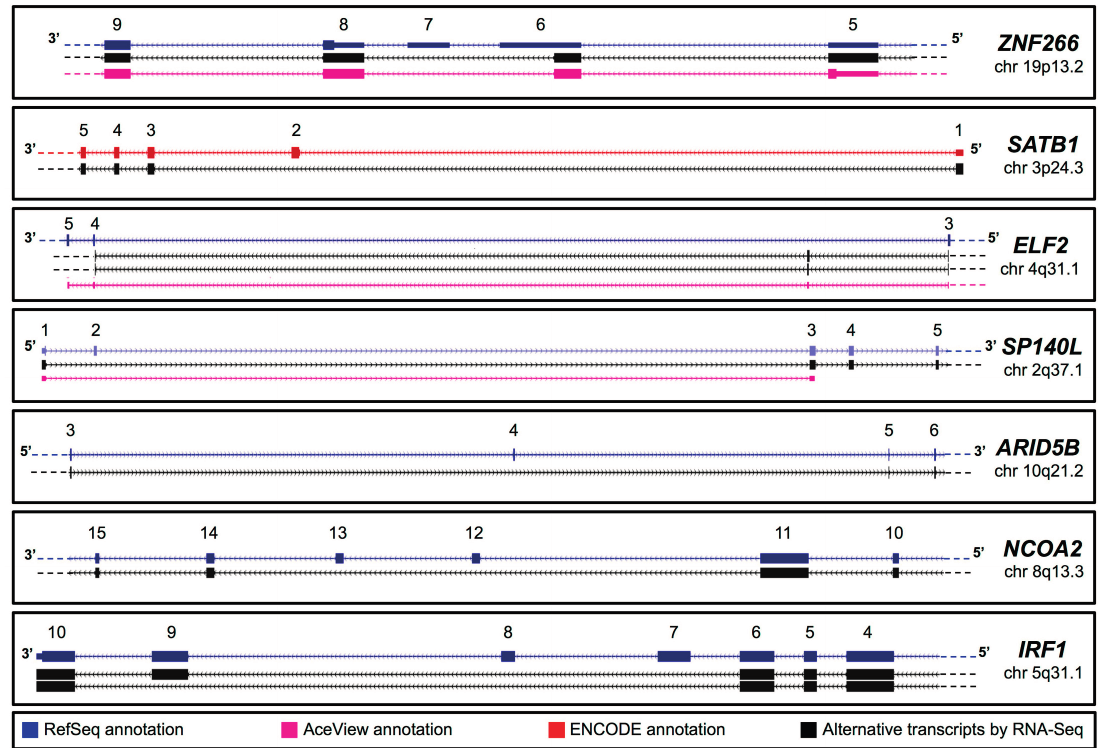
Figure 2. Schematic representation of newly identified TF transcripts. Newly identified transcripts encoding TFs (black)— ZNF266 , SATB1 , ELF2 , SP140L , ARID5B , NCOA2 and IRF1 —are schematically compared to known gene annotations: RefSeq (blue), AceView predictions (purple) and Gencode